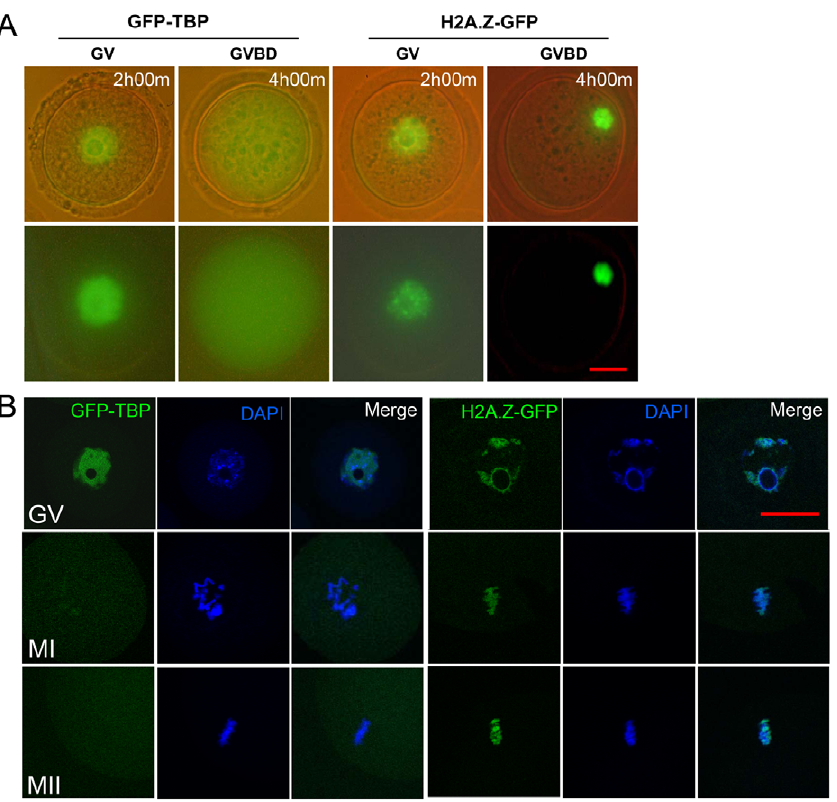
Figure 1. Localization pattern of GFP-TBP in mouse oocytes. ( A ) Time lapse results of GFP-TBP expression during mouse oocyte meiotic maturation. GFP-TBP accumulated in the germinal vesicle after 2 h culture with IBMX but degraded at 4 h with fresh medium, while the control H2A.Z-GFP localized at the chromosomes after 4 h culture. ( B ) Confocal microscopy results of GFP-TBP localization during mouse oocyte meiotic maturation. In the GV stage, GFP-TBP accumulated in the germinal vesicle; in the MI and MII stage, no GFP-TBP signals were found at the chromosomes of oocytes. The control H2A.Z-GFP localized at the chromosomes of MI and MII stage oocytes. Bar=20 m m.